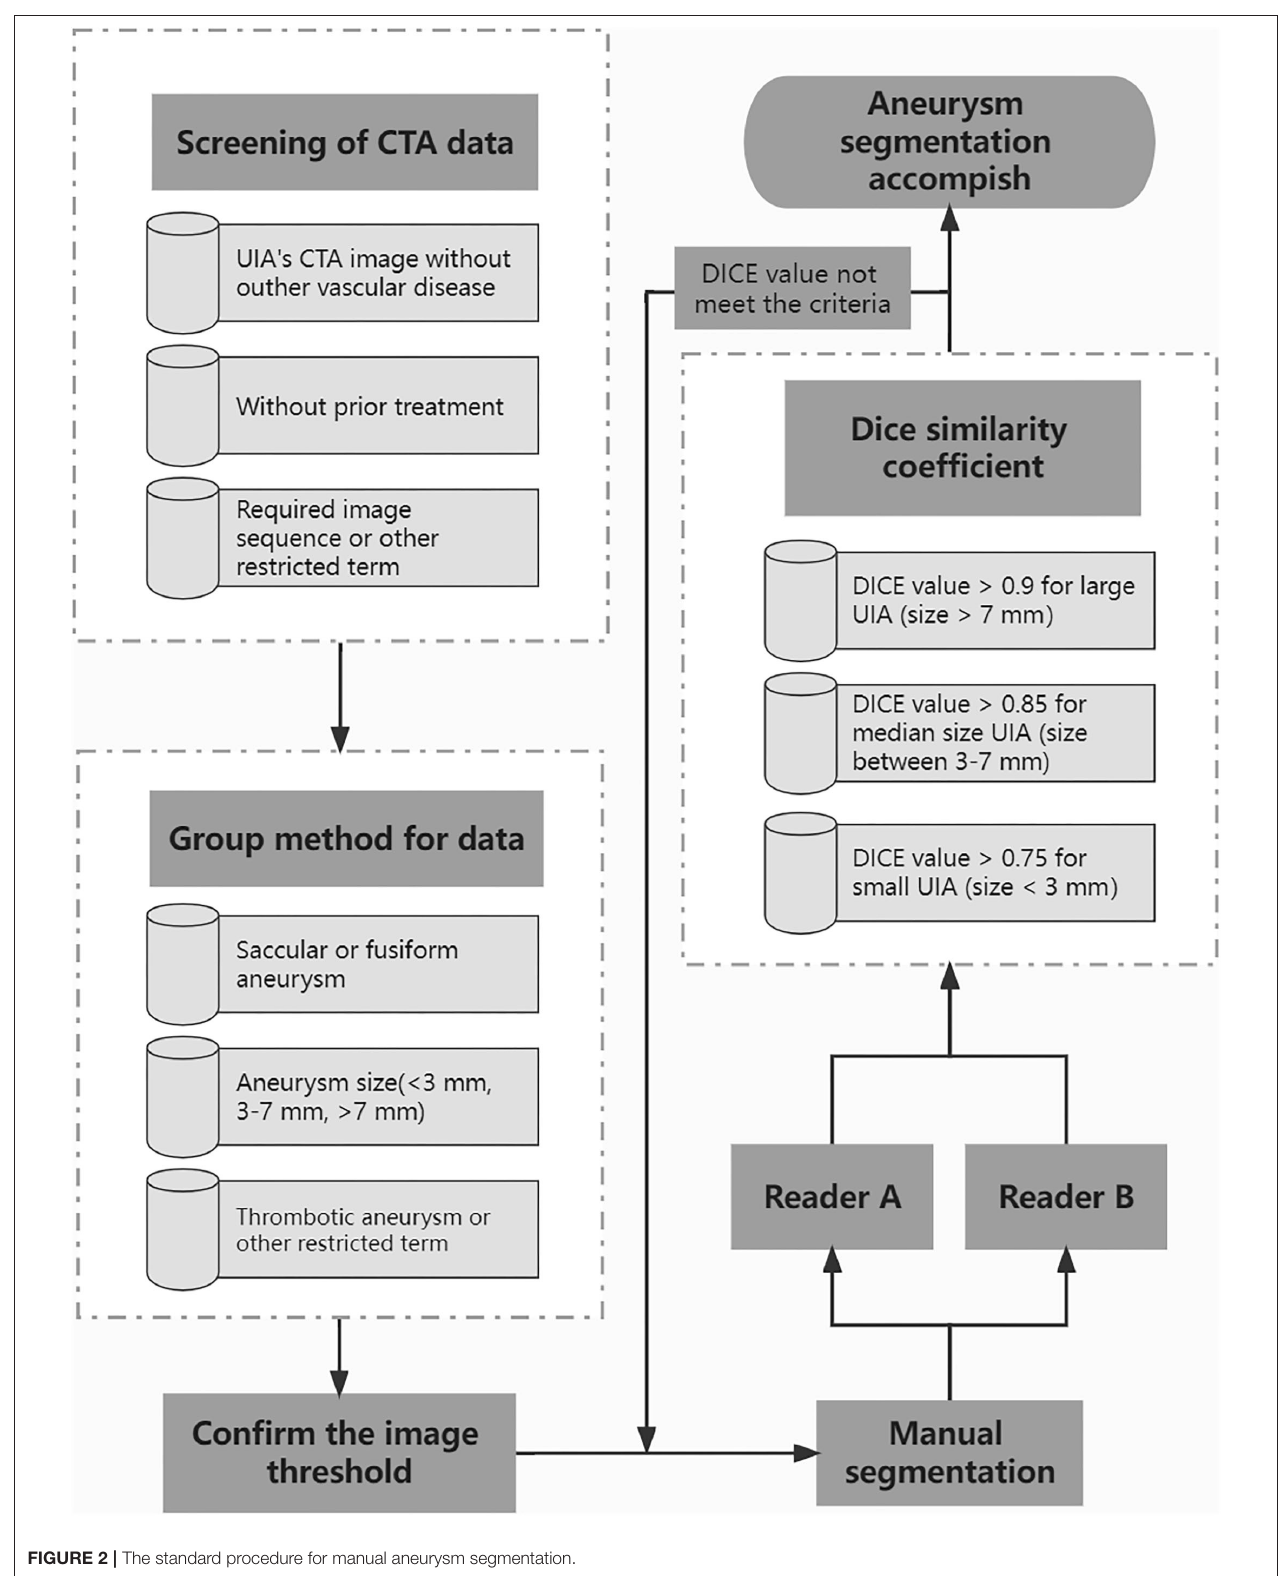
FIGURE 2 | The standard procedure for manual aneurysm segmentation.